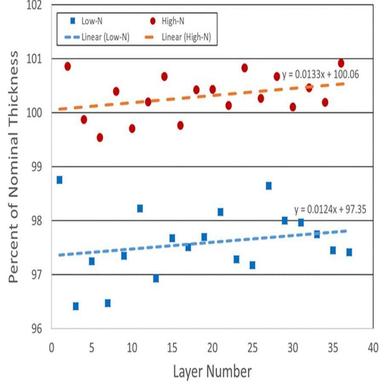
All 37 thicknesses are fit, free of the tooling factor constraint, which achieves an MSE = 39, but at the expense of significantly increased number of fit parameters.